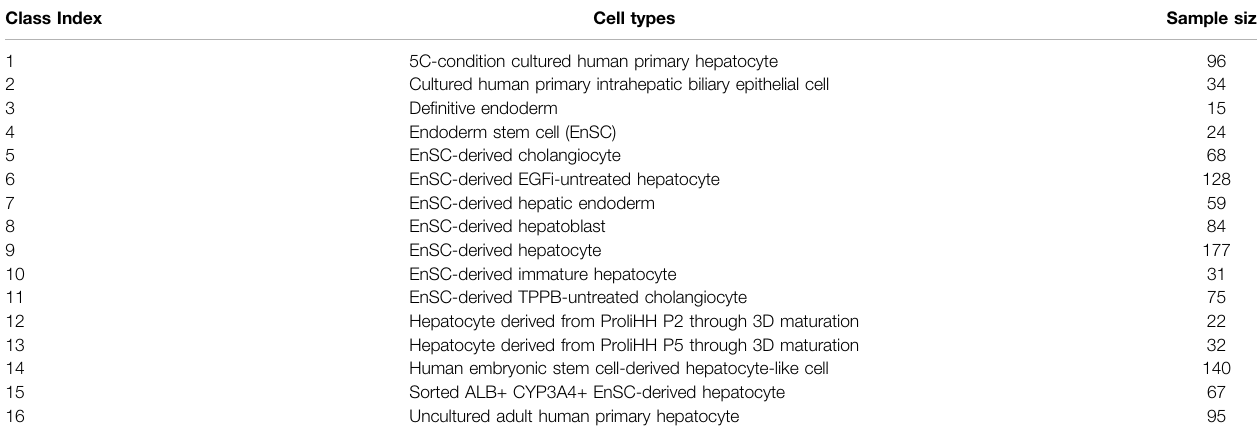
TABLE 1 | The sample sizes of different cell types cultured in vitro